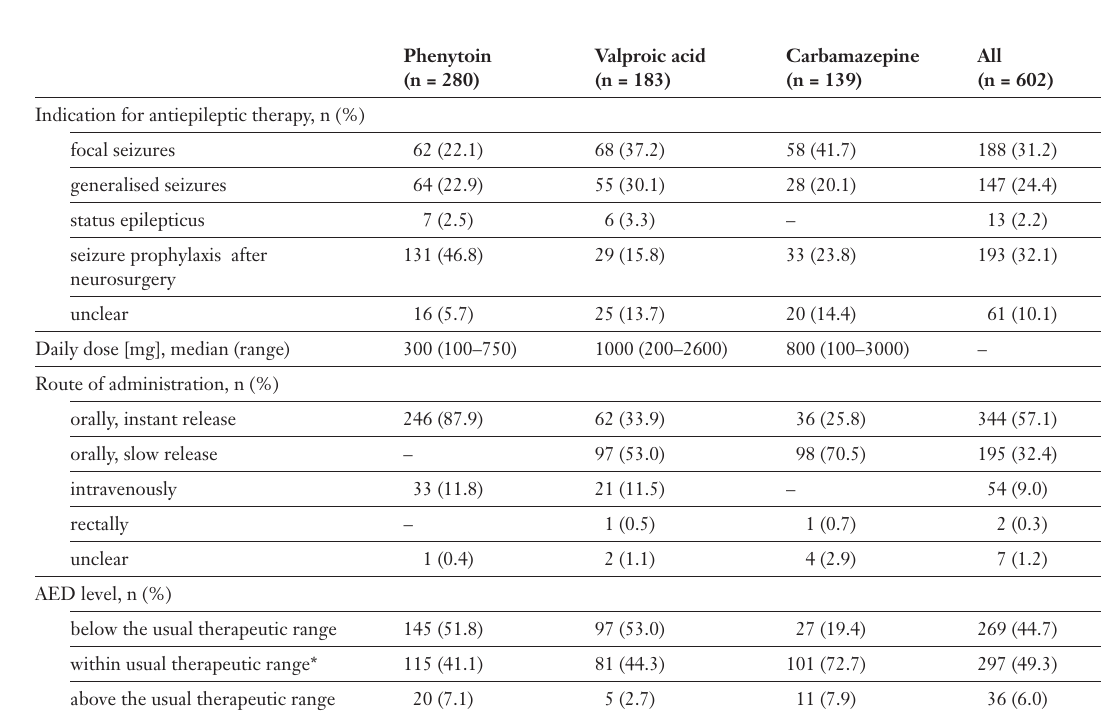
Characteristics of 602 drug level measure- ments of phenytoin, carbamazepine or valproic